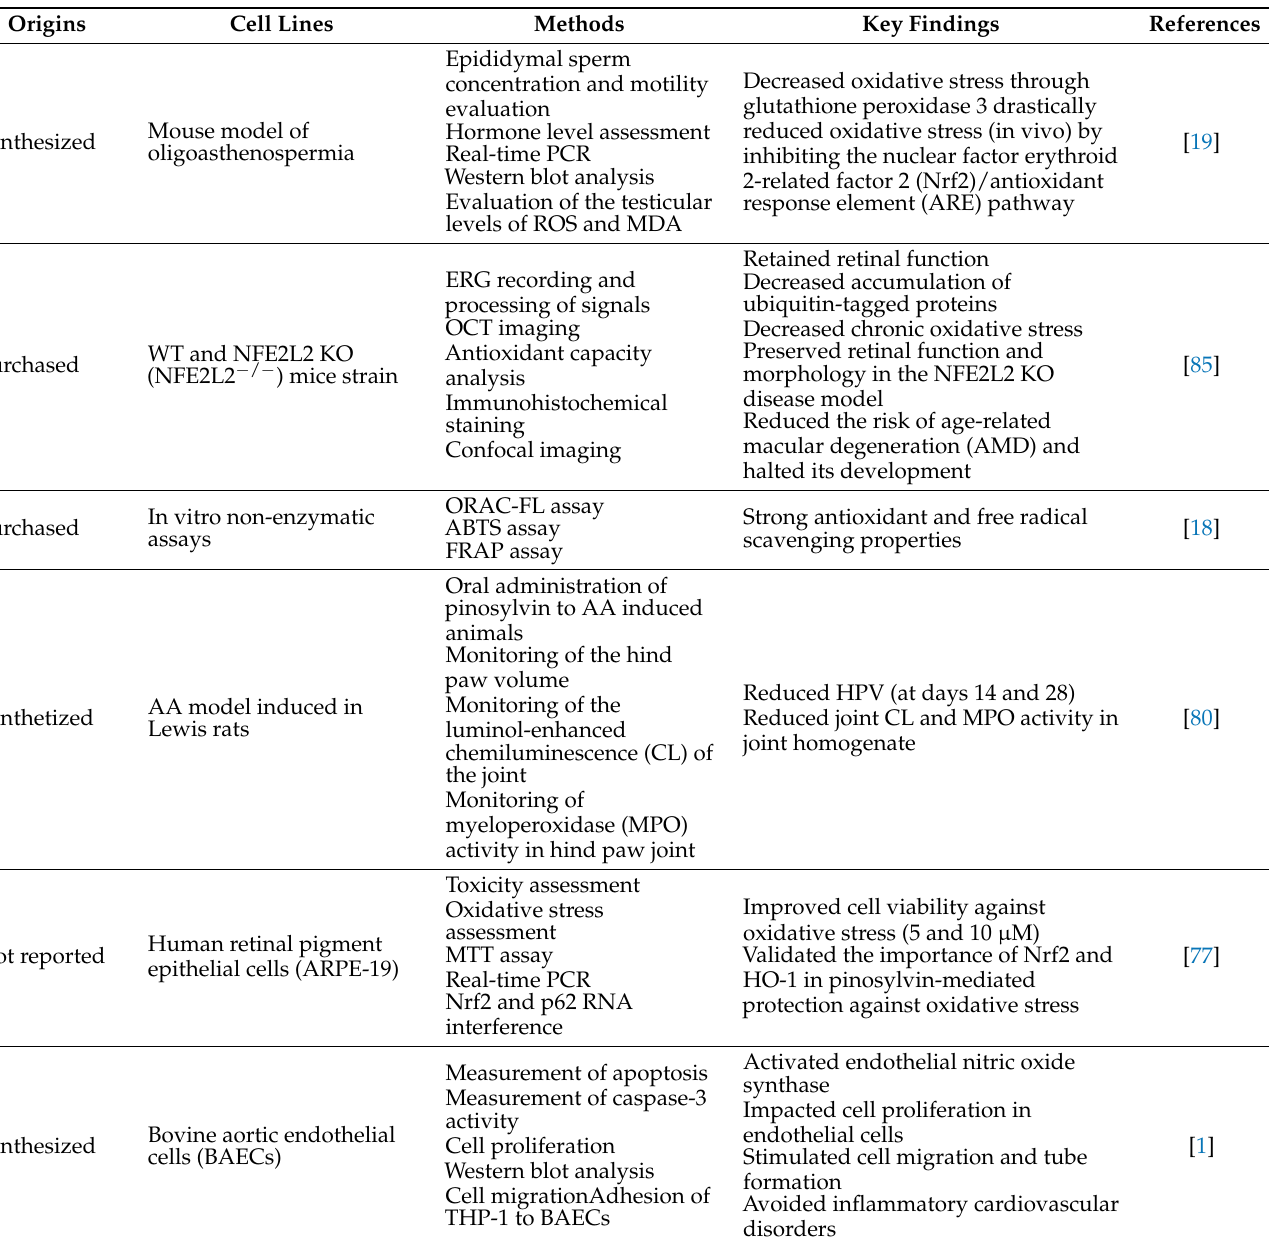
Table 3. Pinosylvin antioxidant